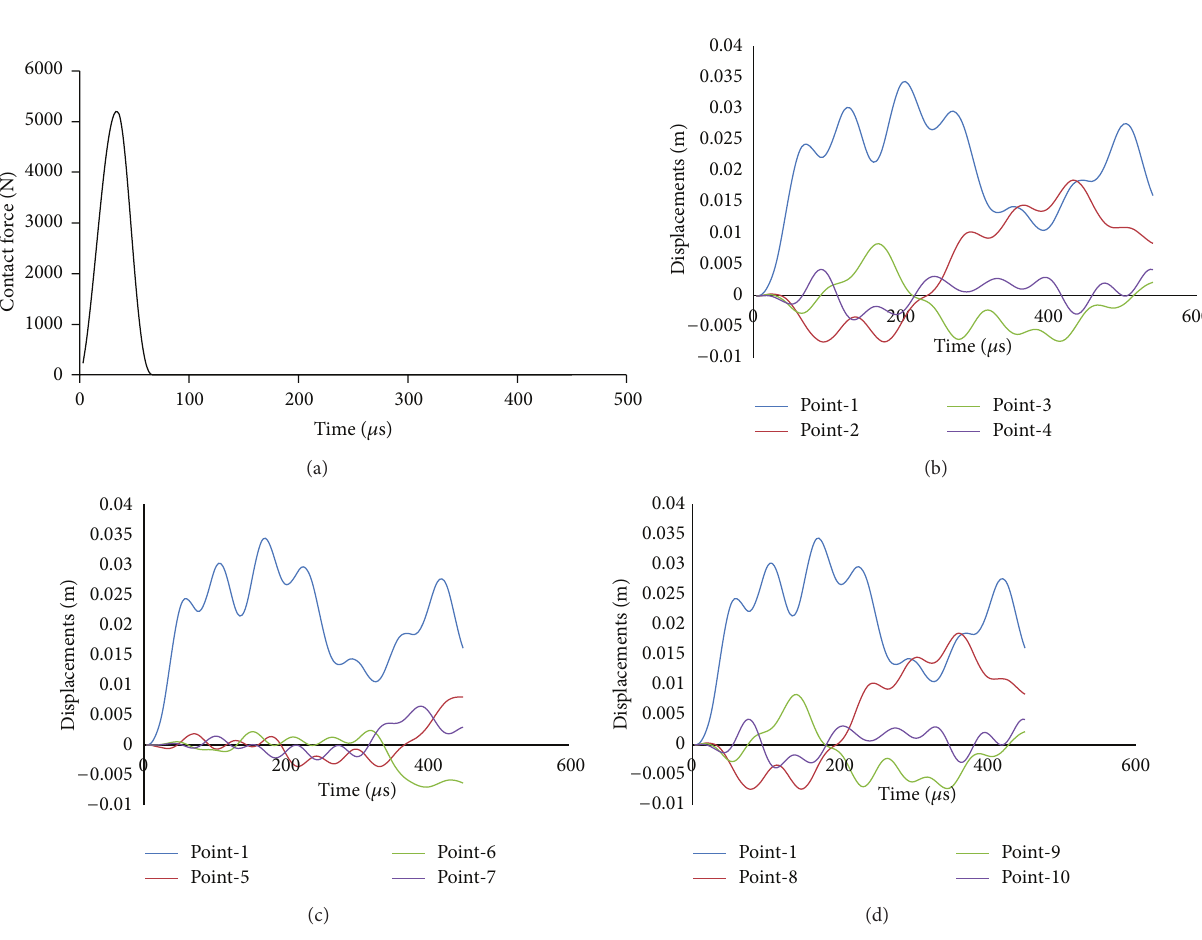
Figure 9: Impact response of clamped cross ply (CL/CP) composite hypar shells for impact velocity